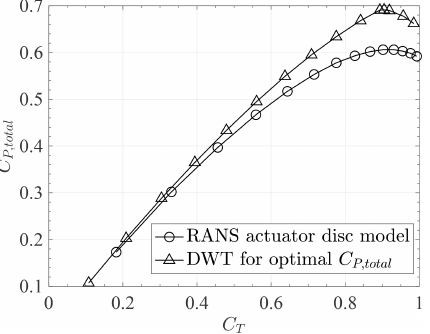
Figure 9. Comparison of C P , total vs. C T for RANS actuator disc model and the DWT for optimal C P , total .